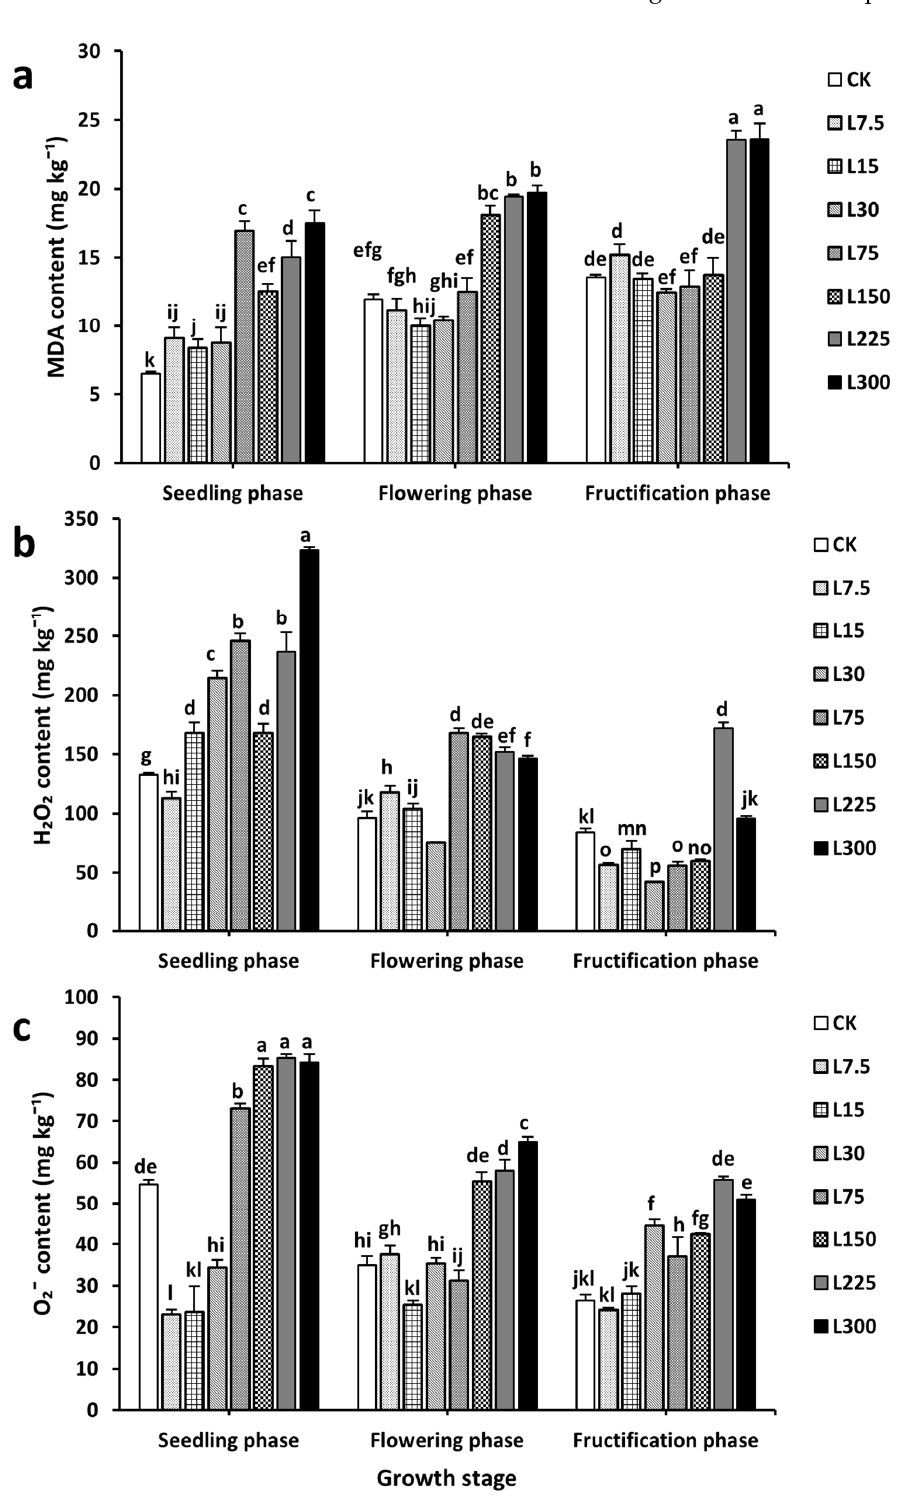
Figure 6. Effect of Cd stress on the active oxygen damage. The leaf for the measurement of ( a ) malondialdehyde, ( b ) H 2 O 2 and ( c ) O 2 − was sampled on days 30 (seedling phase), 79 (flowering